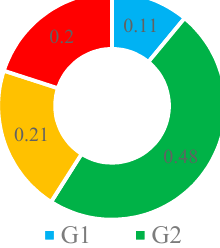
Figure 4. The quantitative distribution of each failure mode.